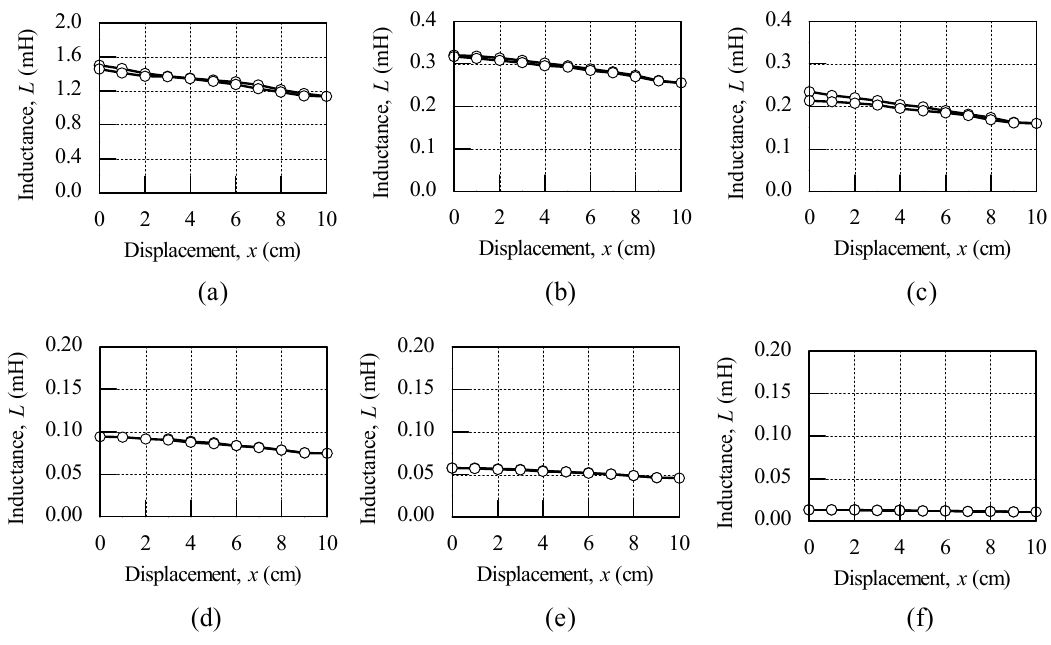
Figure 5. Effect of frequency on inductance characteristic for meander shape inductive coil ( V = 1 V) (a) f = 5 kHz; (b) f = 10 kHz; (c) f = 15 kHz; (d) f = 20 kHz; (e) f = 25 kHz; in (f) f = 50